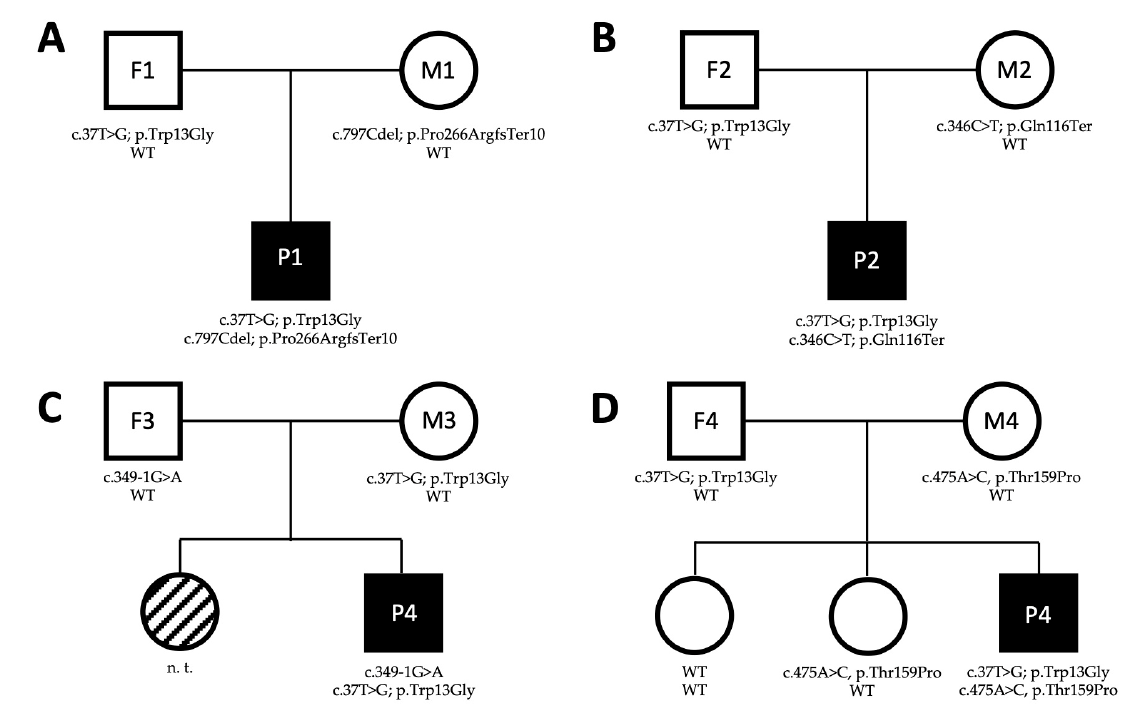
Figure 1. Pedigree of the family of Patient 1 ( A ), Patient 2 ( B ), Patient 3 ( C ), and Patient 4 ( D ). WT: wildtype, n.t.: not tested; square: male, circle: female, white: unaffected, black: affected, striped: isolated tremor.